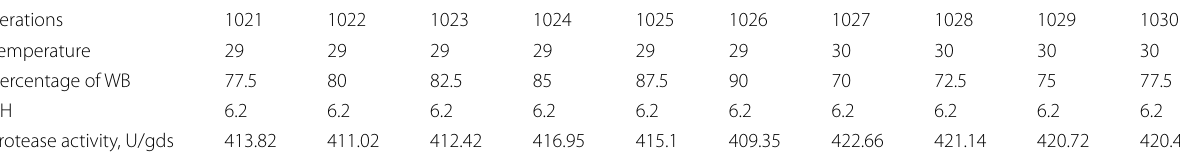
Table 3 Network response of maximum protease activity between 1020th to 1030th iteration Iterations 1021